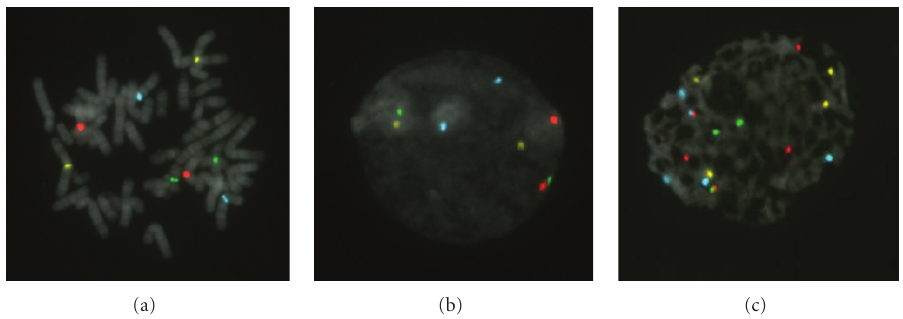
Figure 2: FISH utilizes fluorescent probes to specific areas on chromosomes in cultured cells. Illustrated are OligoFISH probes to the centromeres of chromosomes 2 (yellow), 6 (light blue), 7 (green), and 8 (red). (a) demonstrates the binding to specific chromosomes in a metaphase spread; (b), binding to DNA sequences in a normal diploid human cell, and (c), binding to sequences in a cell with an abnormally increased chromosomal